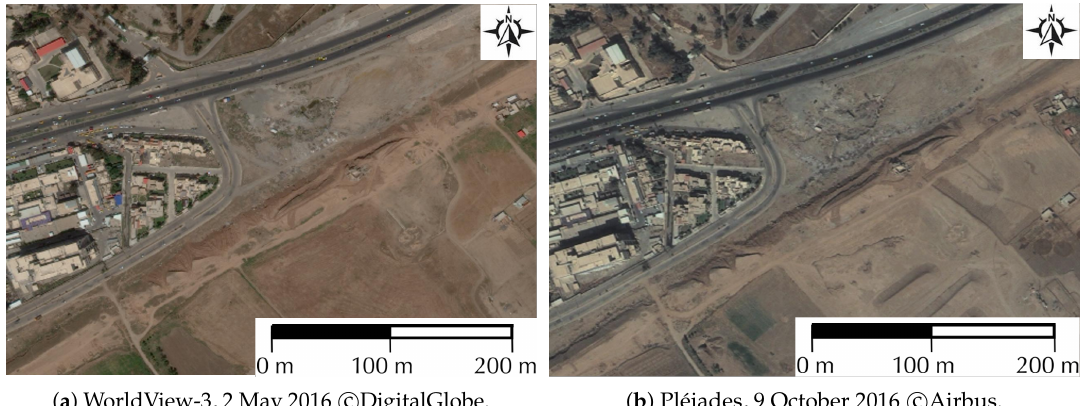
Figure 27. Satellite imagery of Adad Gate (2016).